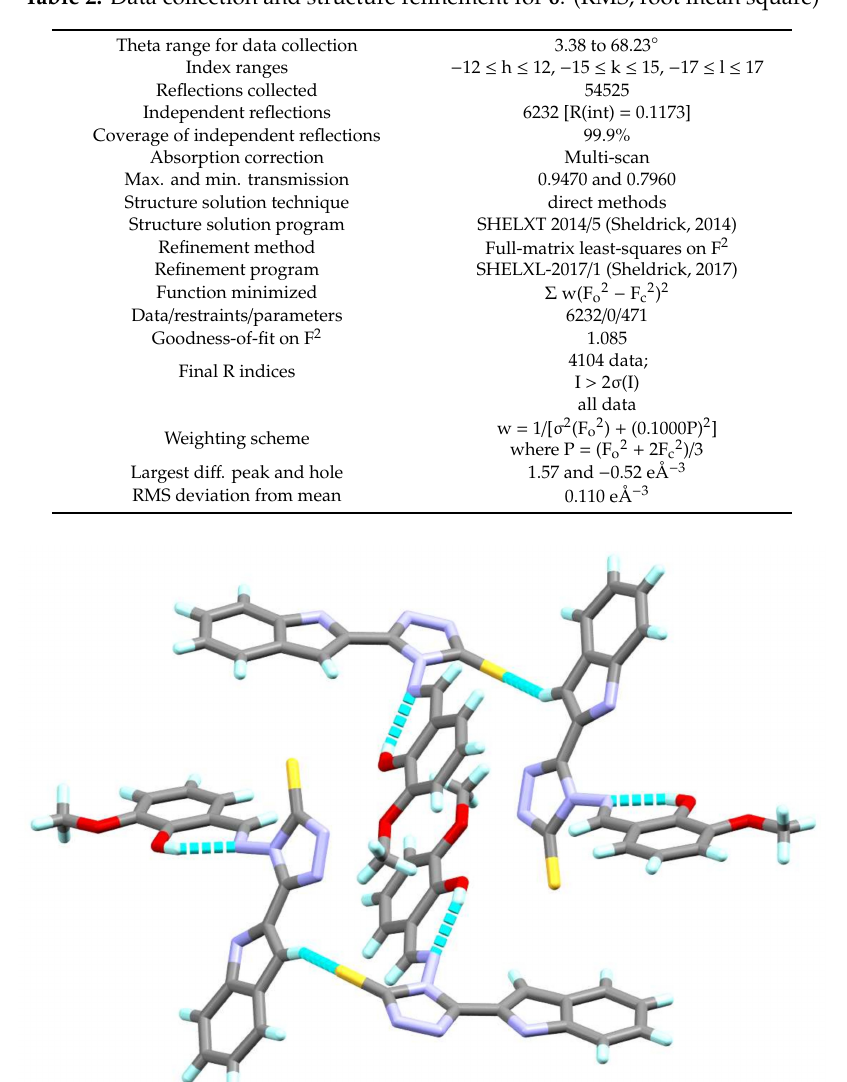
Table 2. Data collection and structure refinement for 6 . (RMS, root mean square)